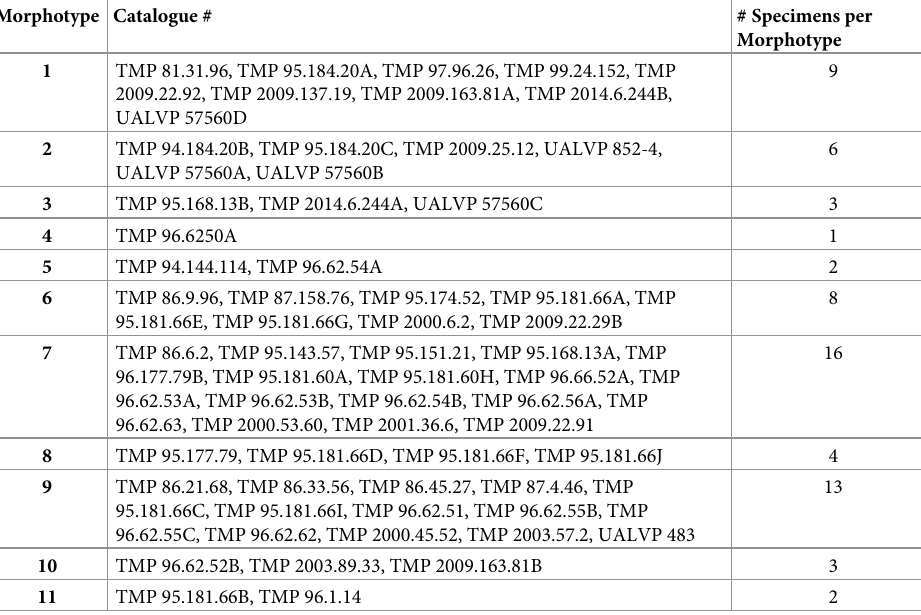
Table 2. List of specimen numbers with their corresponding